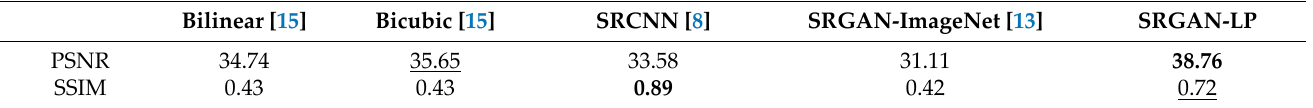
Table 3. Average PSNR (dB) and SSIM of 100 reconstructed test images for the real test set. Bold scores show the best results and underlined values represent the second best